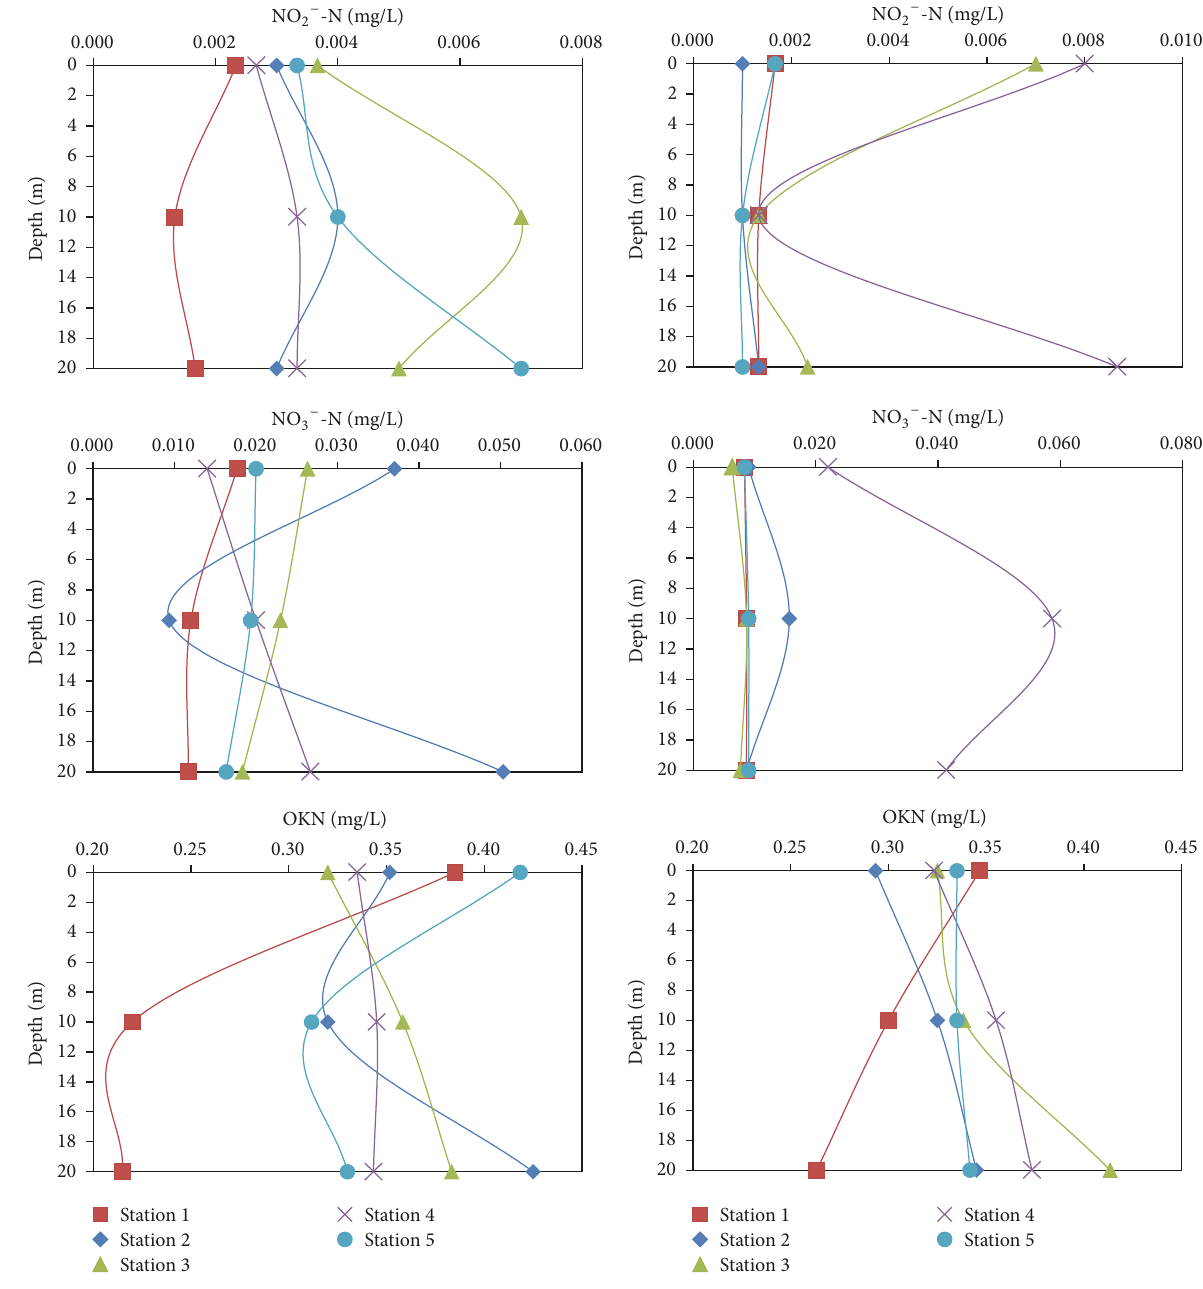
Figure 5: The distribution of NO 2− -N, NO 3− -N, and OKN at three different depths (0, 10, and 20 m) of Bakun Reservoir in February (a) and September (b)